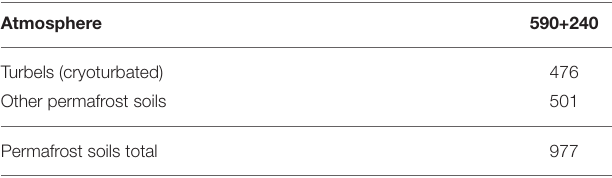
TABLE 1 | Comparison of carbon stocks in permafrost soils and in particular in cryoturbated soils (turbels) according to Hugelius et al. (2014) to carbon stocks in the atmosphere (Ciais et al.,